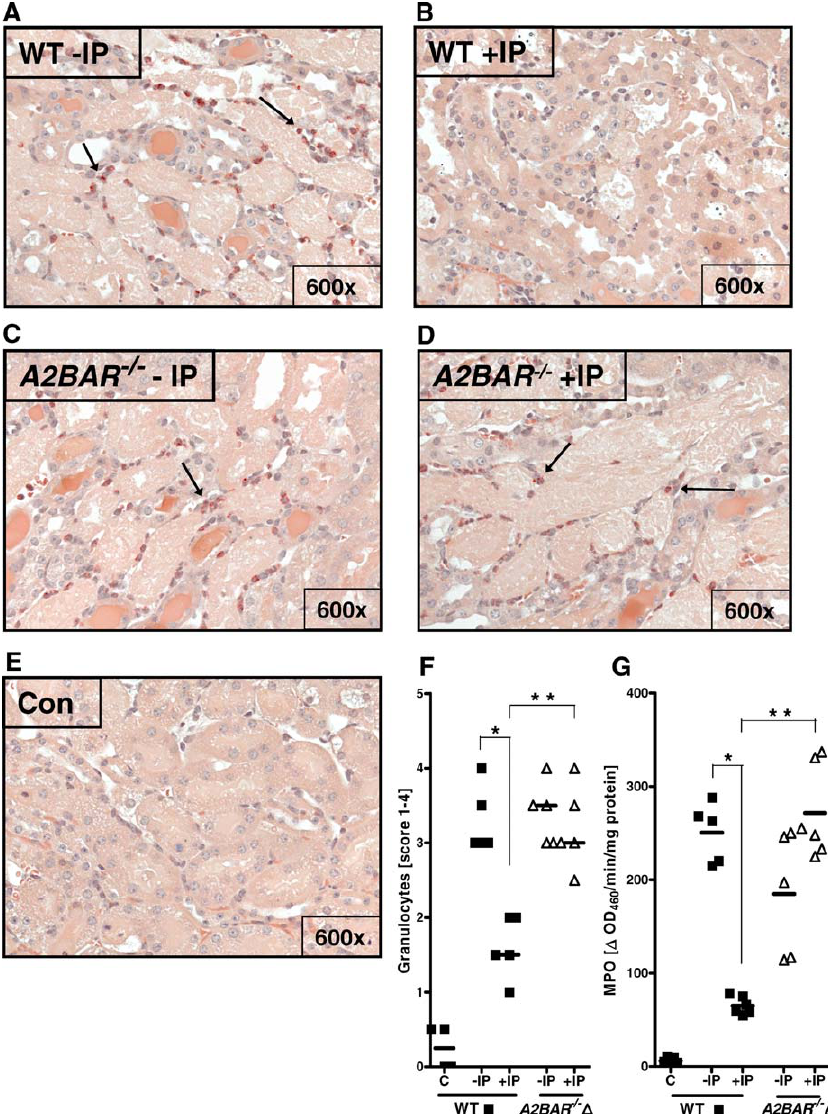
Figure 4. Inflammatory Changes in A2BAR (cid:2) / (cid:2) Mice during Renal Preconditioning A2BAR (cid:2) / (cid:2) mice and their respective age-, weight-, and gender-matched littermate controls (WT) were subjected to right nephrectomy followed by 45 min of left renal artery ischemia with or without prior in situ IP (consisting of four cycles of 4 min ischemia followed by 4 min reperfusion). (A–E) Chloracetate esterase staining. Arrows indicate granulocytes (magnification 600 3 ). (F) Quantification of granulocyte accumulation. (G) Quantification of neutrophil tissue accumulation by measurement of myeloperoxidase (MPO). Statistics: (F) Kruskal-Wallis nonparametric analysis (chi-square ¼ 17.86, df ¼ 4, p ¼ 0.001) with follow-up pairwise comparisons by Wilcoxon-Mann- Whitney test was performed with *, p , 0.01 versus WT þ IP and **, p , 0.01 versus the A2BAR (cid:2) / (cid:2) mice with IP. (G) One-way ANOVA with Tukey’s post-hoc test was performed (*, p , 0.001 versus WT þ IP; **, p , 0.001 versus the A2BAR (cid:2) / (cid:2) mice with IP). The F -test result is F (4,22) ¼ 46.26, p , 0.001.